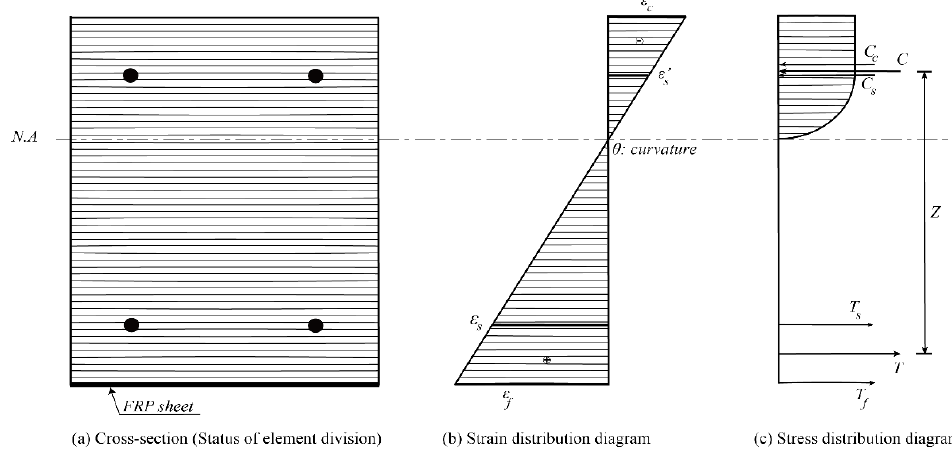
Figure 8. Calculation of the load-deflection curve.